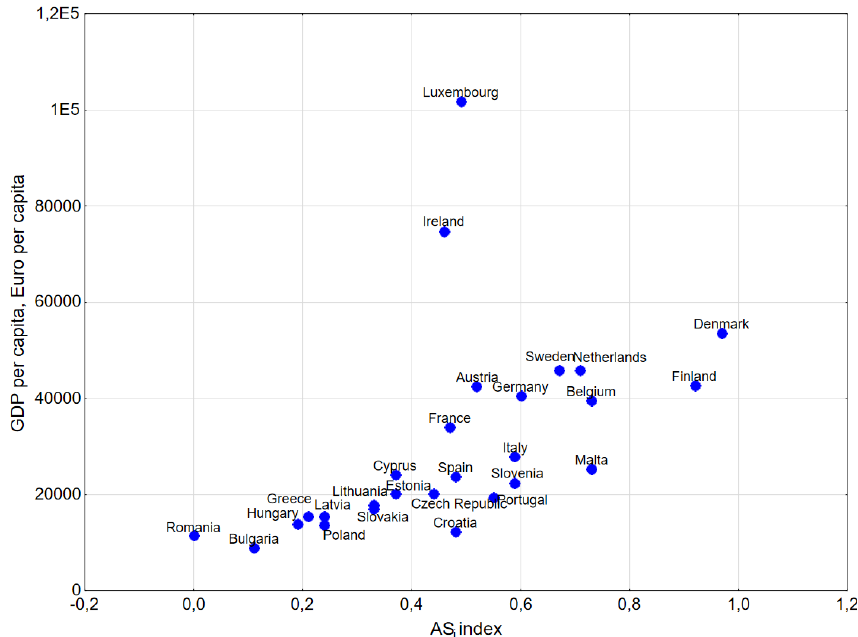
Figure 10. The relationship between GDP per capita of the EU-27 countries and the value of digital maturity index of their SMEs.